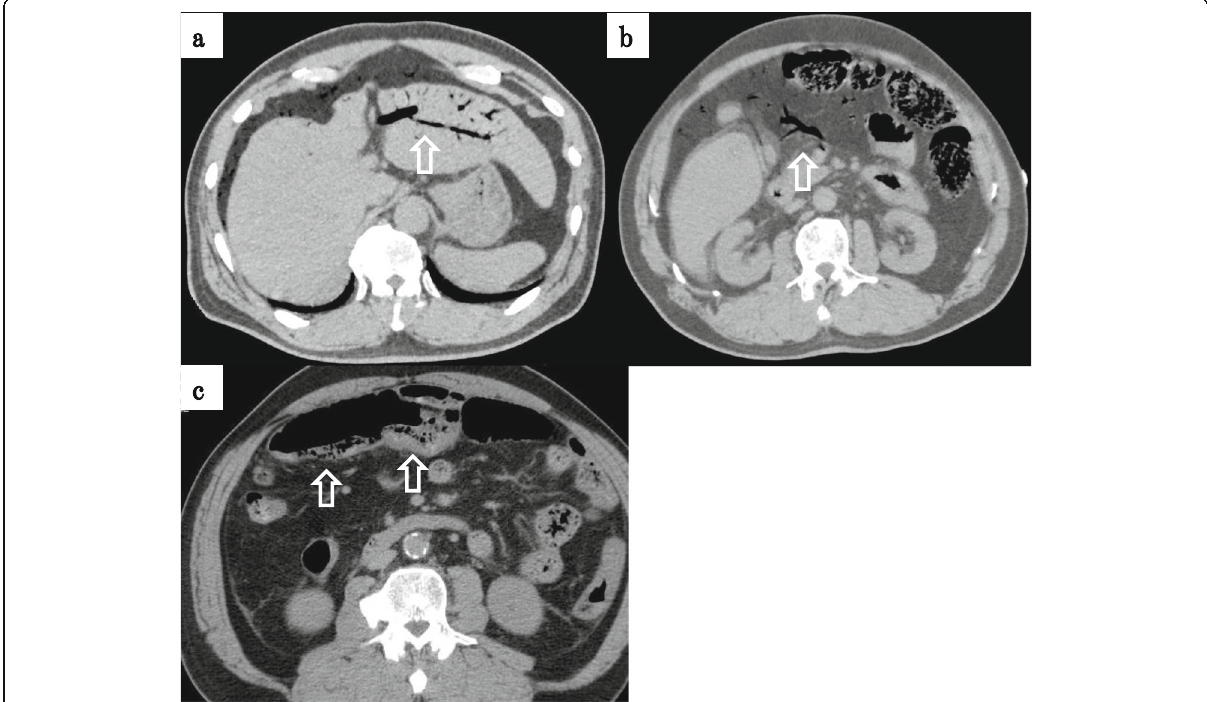
Fig. 1 CT imaging before HBOT. a A large amount of intravenous gas was detected in the portal vein (white arrow) and b superior mesenteric vein (white arrow). c CT imaging after transfer to our hospital revealed pneumatosis intestinalis of the transverse colon (white